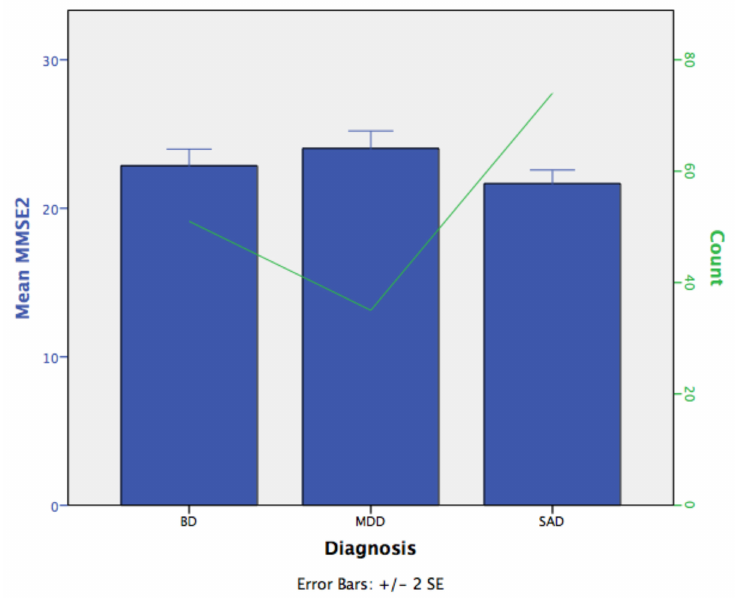
Figure 1. The standard errors (SEs) of the means of mini-mental state examination (MMSE-2) scores across the diagnosis